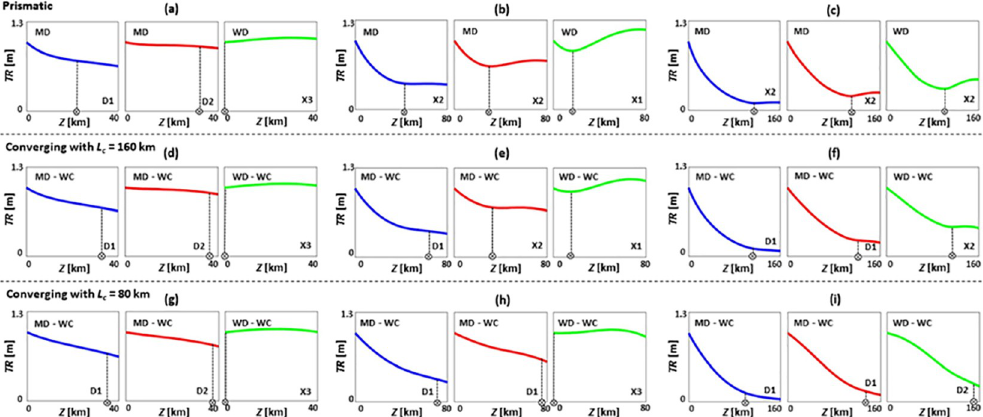
Fig 6. Tidal range TR patterns of prismatic (a-c), converging with L = 160 km (d-f), and converging with L = 80 km (g-i) c c estuaries under SLR, where TR 0 = 1 m, Q / TP = 10% (high river discharge), n = 0.015 s/m 1/3 , h = 5 m, and θ = 0˚. (a), (d), and (g) are short estuaries ( Z = 40 km); (b), (e), and (h) are moderate estuaries ( Z = 80 km); and (c), (f), and (i) are long estuaries ( Z = 160 km). Blue, red, and green colours show base case (no SLR), 1 m of SLR, and 2 m of SLR scenarios, respectively. Patterns X1, X2, X3, D1, and D2 are the general TR patterns introduced in Fig 2. WD, MD, and WC refer to weakly dissipative, moderately dissipative, and weakly converging estuaries,